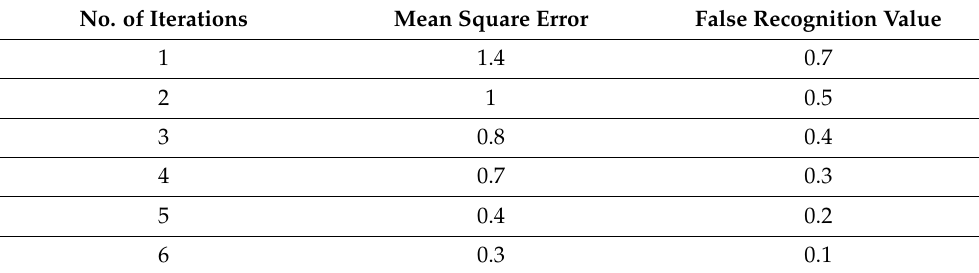
Table 1. LPRNN training results, both mean square error and false recognition rate.